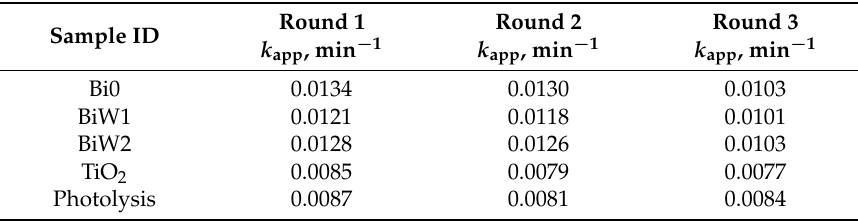
Table 3. Pseudo-first-order apparent constant rates ( k app ) for methylene blue photocatalytic removal after three times of use ( R 2 ≥